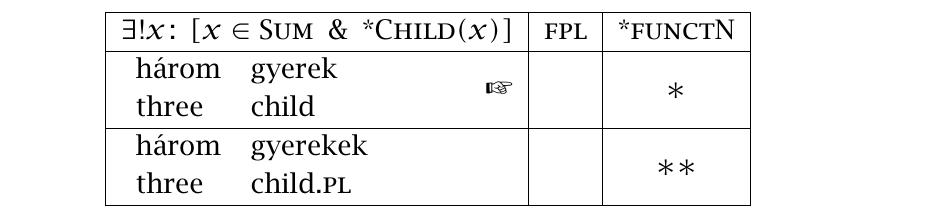
Tableau 3 expressive optimization for plural cardinals